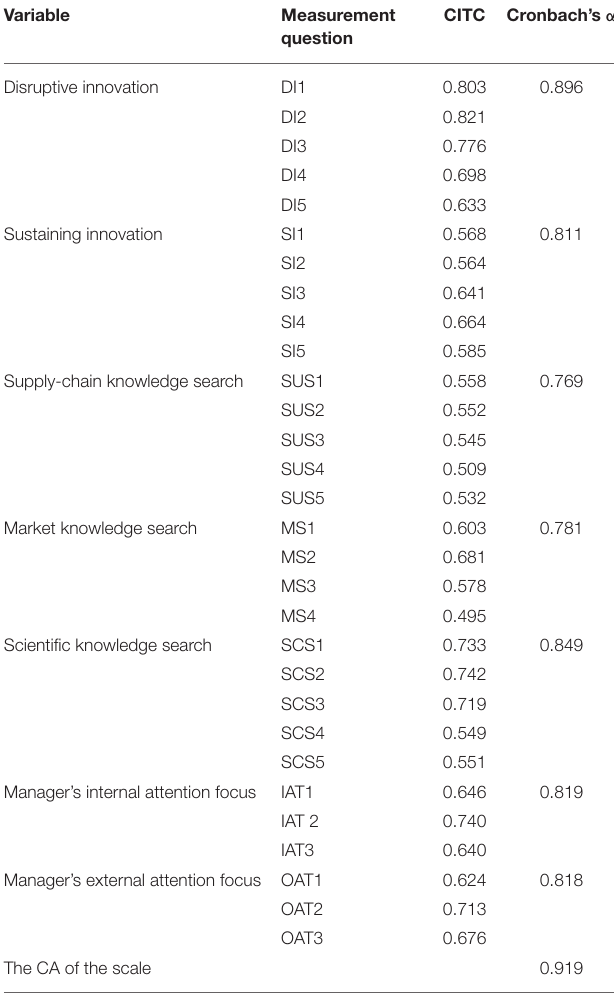
TABLE 1 | Reliability test results of subscales and